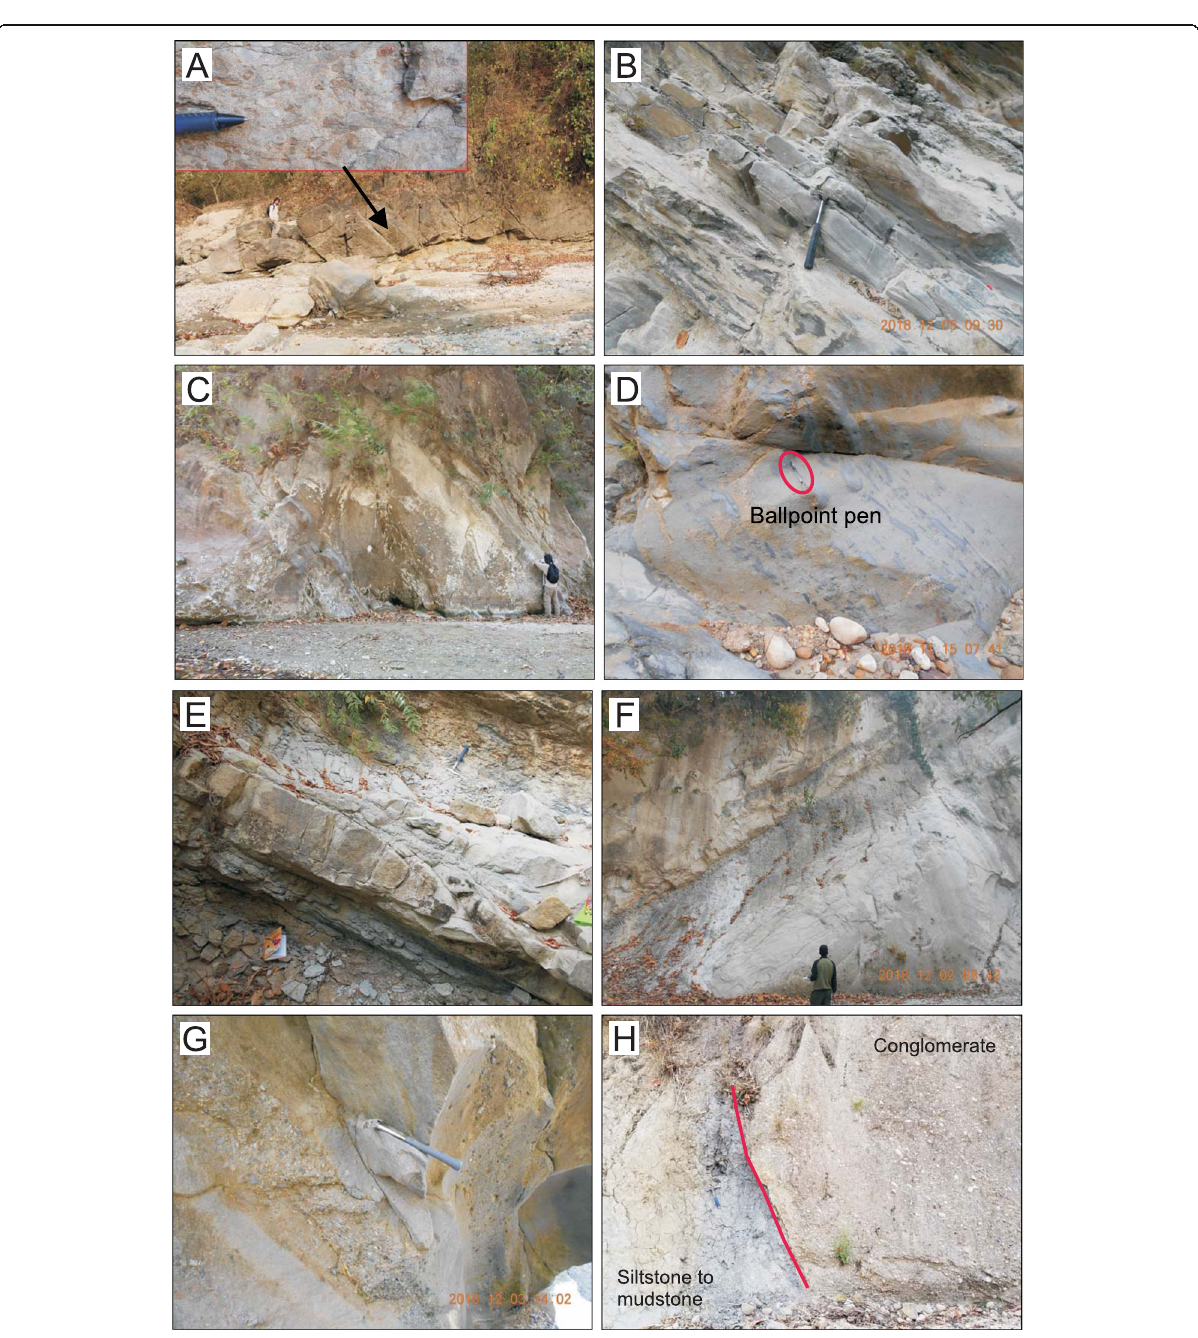
Fig. 4 Outcrop photographs of A intraformational conglomerate with mud clast observed in FA2, B fine-grained sandstone with parallel to ripple cross-lamination representing levee deposits of FA2, C amalgamated sandstone bed observed in FA3, D subangular to angular mud clast observed on the base of amalgamated sandstone of FA3, E lateral accretion observed in sandstone bed of FA3, F fining-upward sequence observed in a very thick bed of sandstone of FA4, G sandstone beds with channel lag deposits observed in FA4, H siltstone to mudstone bed and matrix-supported pebble to cobble conglomerate of